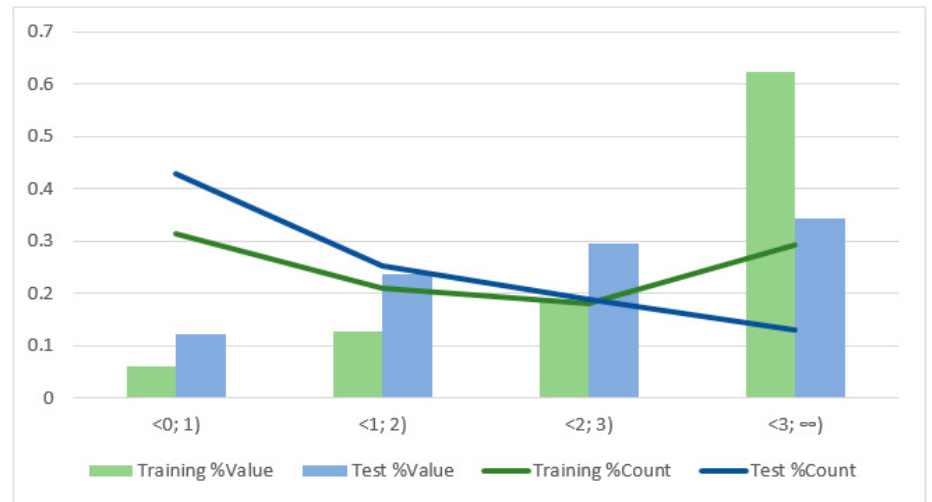
Figure 2. Percentage share of the number and the value of losses within the particular range, for training set and test set.